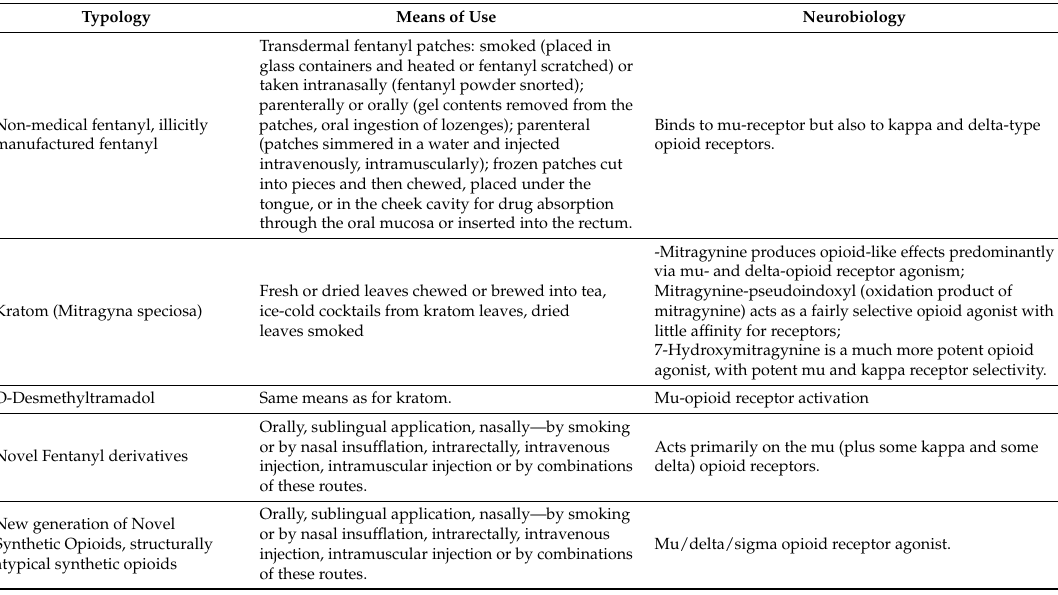
Table 2. Common characteristics of NSOs: means of use, neurobiology, and intentionality of use.